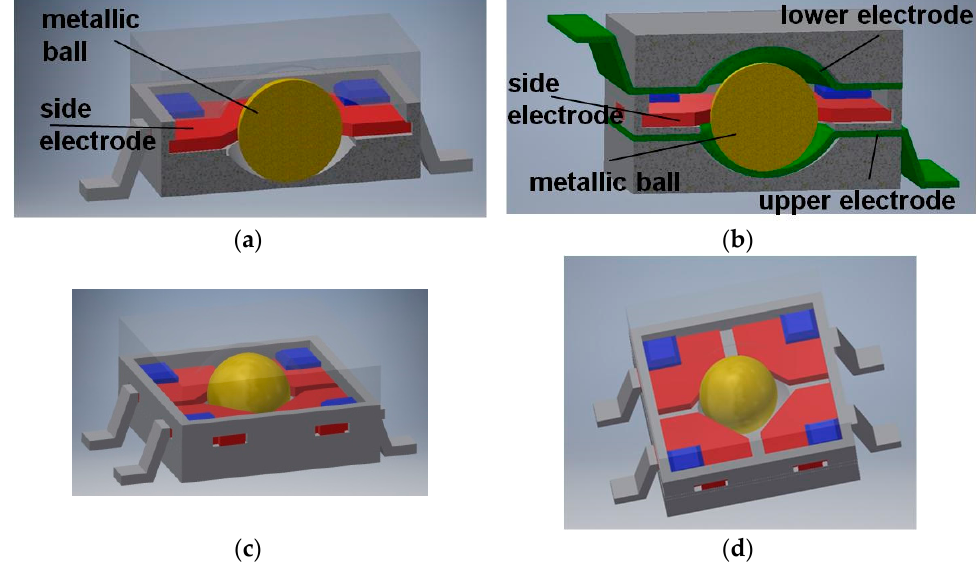
Figure 4. Dual-axis tilt switches: ( a ) with four electrodes; ( b ) with six electrodes; ( c ) arrangement of the side electrodes; ( d ) principle of